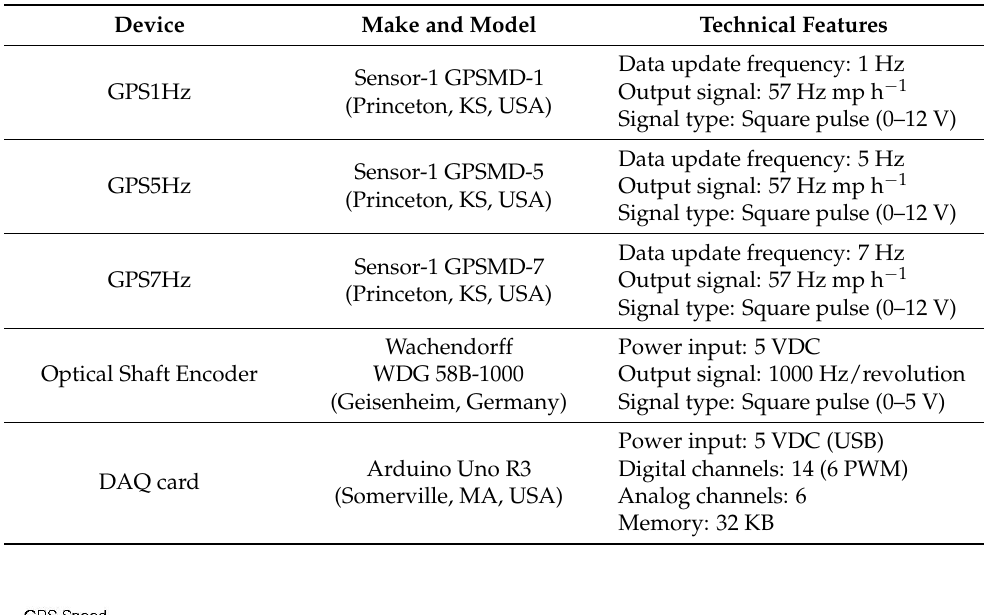
Table 1. Some technical features of the three GPS speed sensors, optical shaft encoder and DAQ card used in the study.